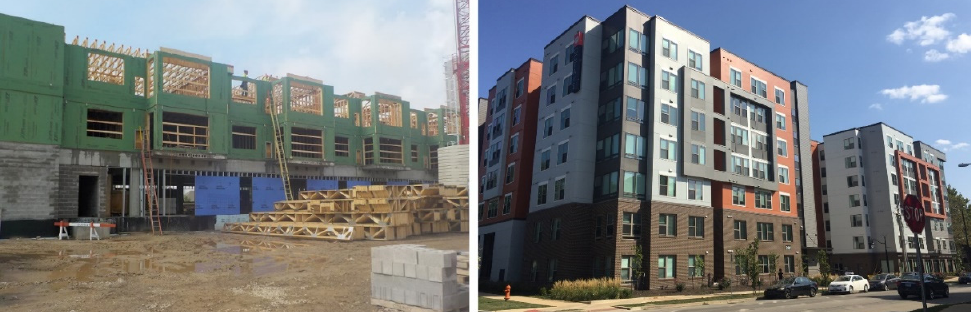
Figure 1. A multifamily housing project with light wood framing installed over a non-combustible podium in Sheboygan, WI ( Left ); 5 floors of light wood framing above a two-floor podium in Champaign, IL ( Right ).